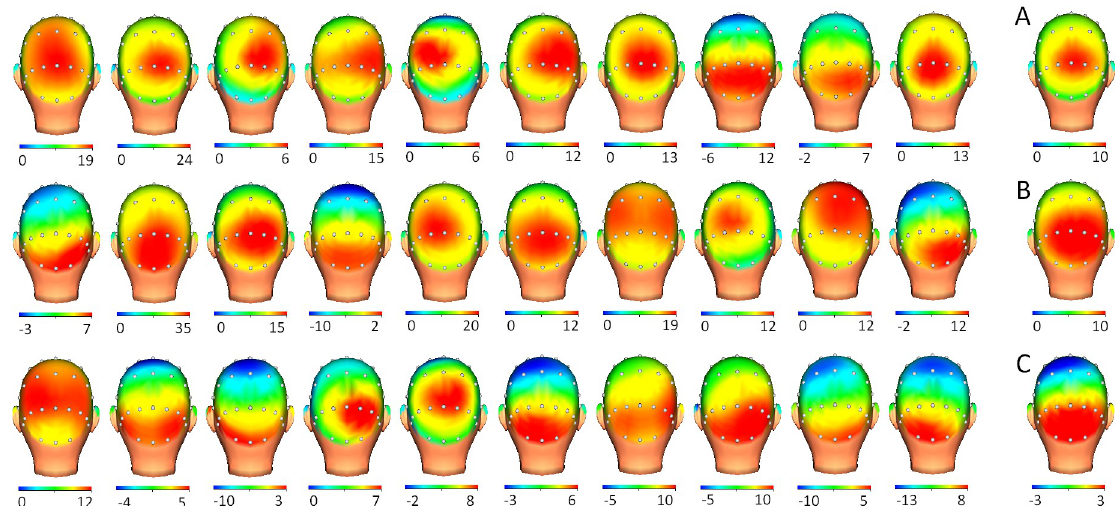
Fig 3. Grand average and individual 3D head maps of P3 for healthy, low- and moderate-EDSS groups. 3D head maps are displayed for each of the 10 participants of each group (upper line: healthy group; midline: Low EDSS group; bottom line: Moderate EDSS group) and the grand average for each group (A): healthy; (B): Low EDSS and (C) Moderate. Note that the topography for GA is moved to more posterior areas as disability (EDSS) increases.